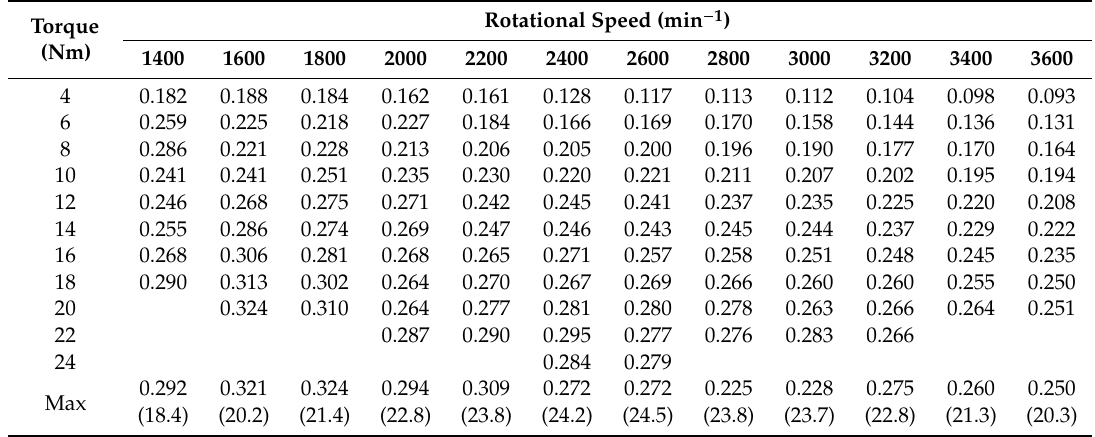
Table A4. Thermal e ffi ciency of range extender supplied with gasoline.